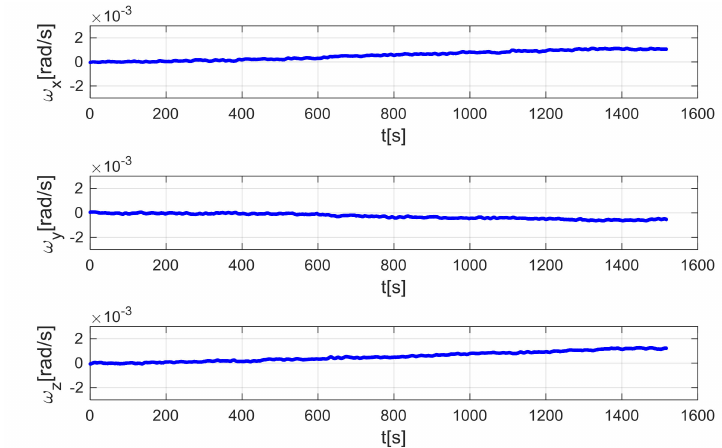
Figure 9. Input data of the standard ZUPT filter.